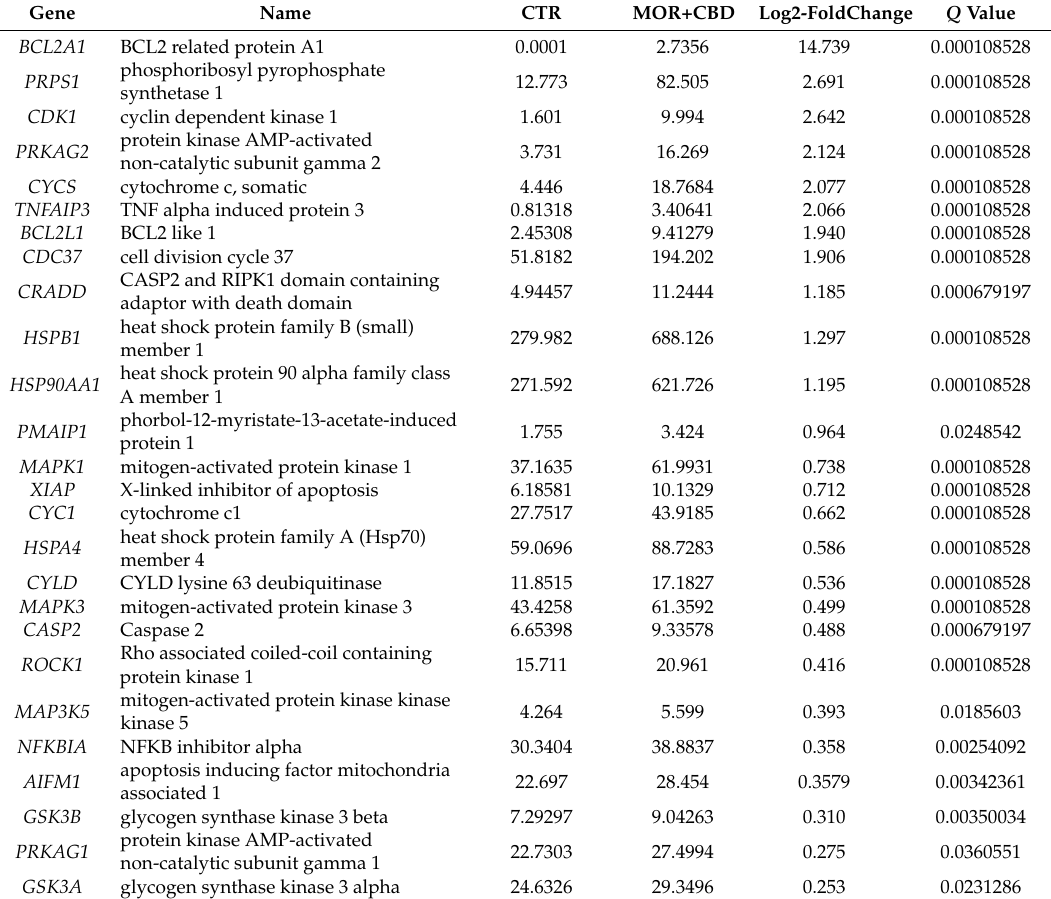
Table 2. Upregulated genes involved in “Inhibition of Apoptosis”.